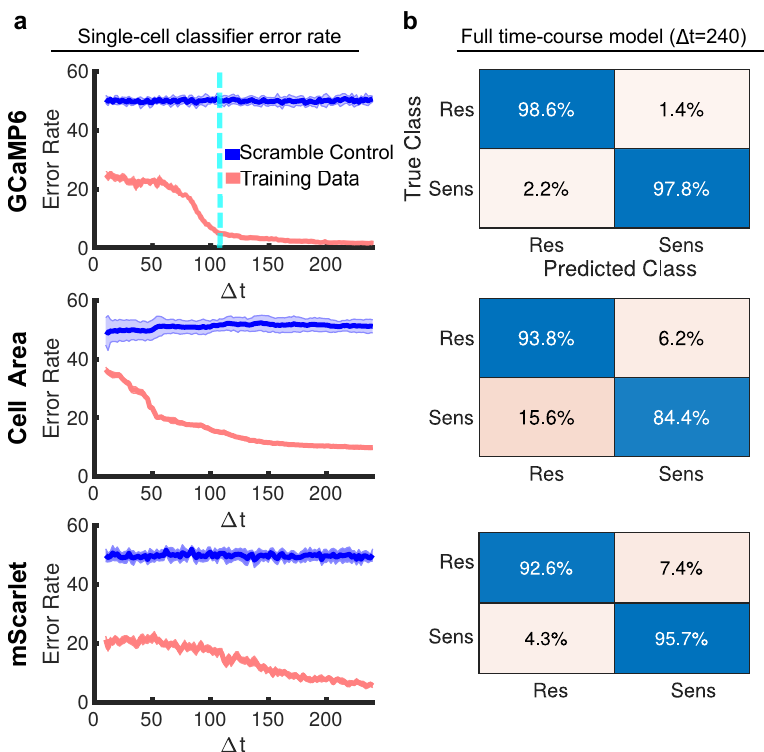
Figure 5. Using machine learning to discriminate kanamycin sensitive from resistant cells at single-cell resolution. ( a ) Comparing the error rate of machine learning classifiers as a function of ∆ t for GCaMP6, cell area, and mScarlet traces. A random forest classifier with AdaBoostM1 boosting (Figure 2) was used for the GCaMP6 and mScarlet traces while an SVM was used for cell area (see Methods). As the amount of the trace included in training the classifier increases (i.e., ∆ t increases), the total error rate of the classifier decreases (red curve). The hyper-parameters are the same for all ∆ t classifiers. The blue curve is the error rate of the same random forest architecture trained on scrambled cell labels. As expected, the classifier cannot improve upon a 50/50 guess when the traces are scrambled. This demonstrates the information content is unique to the Ca 2 + dynamics. Shaded error bars are the standard deviation in the error rate calculated between 10-folds (80/20 split). Dashed, cyan line marks when the error rate for GCaMP6-based classifier is first below 5% (108 min). Neither cell area nor mScarlet signals achieve a <5% error rate in single-cell classification. ( b ) Confusion matrices for the full time-course classifiers based on the GCaMP6 trace ( top ), cell area ( middle ), and mScarlet trace ( bottom ). The confusion matrix was calculated based on a 20% subset of all cell traces withheld from the training dataset. Training used an 80/20, 10-fold cross-validation scheme. A total of 7557 and 4969 resistant (Res) and sensitive (Sens) single-cell traces were used for testing and